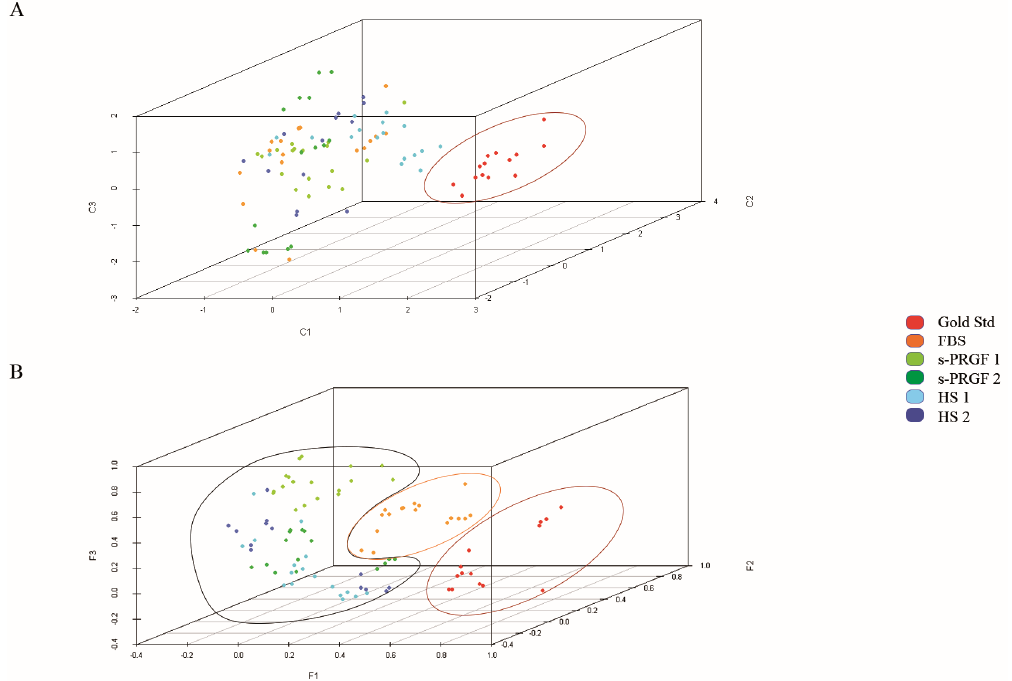
Figure 4. Representation of all samples in three components obtained by ( A ) Principal component analysis (PCA); ( B ) Partial least squares discriminant analysis (PLS-DA). Colors indicate treatments. Cultures following the gold standard culture methodology are separated from cultures following explants culture